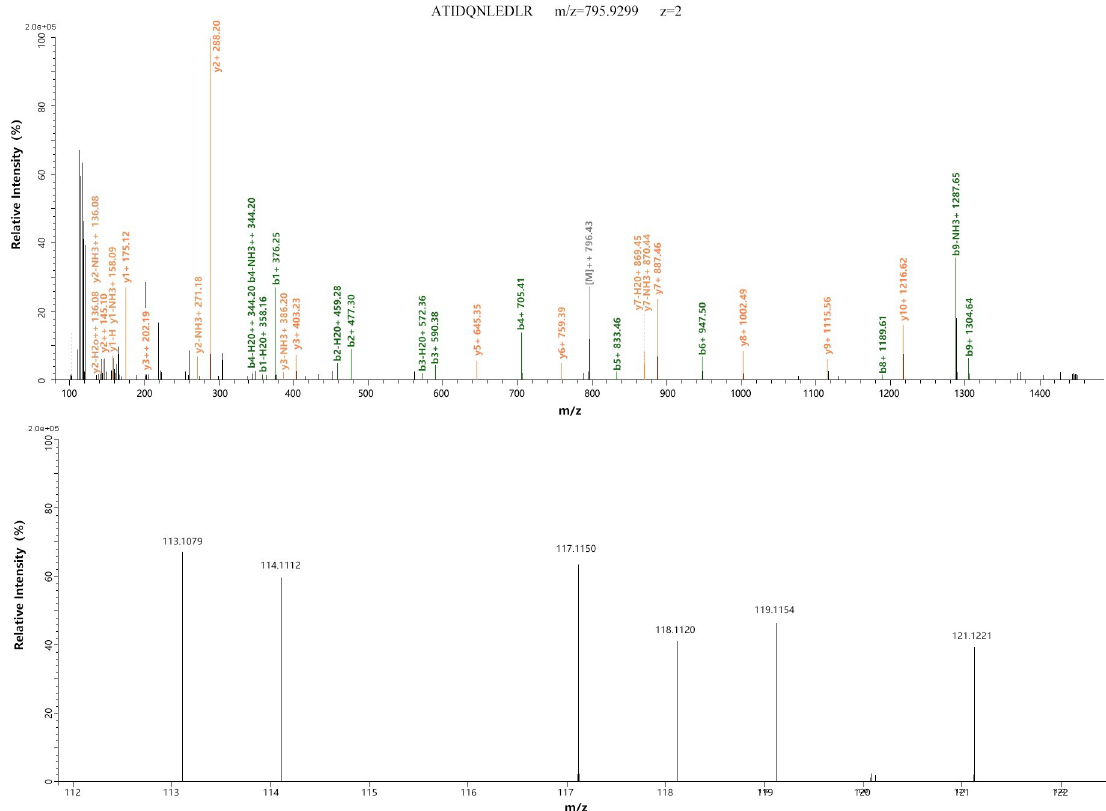
Fig 1. MS/MS spectra of APOA4. MS/MS spectra used for the identification and quantitation of APOA4 with 113, 114 and 117 tags for CIH samples, and 118, 119 and 121 tags for control samples. Top, the MS/MS spectra of precursor ion ATIDQNLEDLR for identifying APOA4. Bottom, relative quantitation of